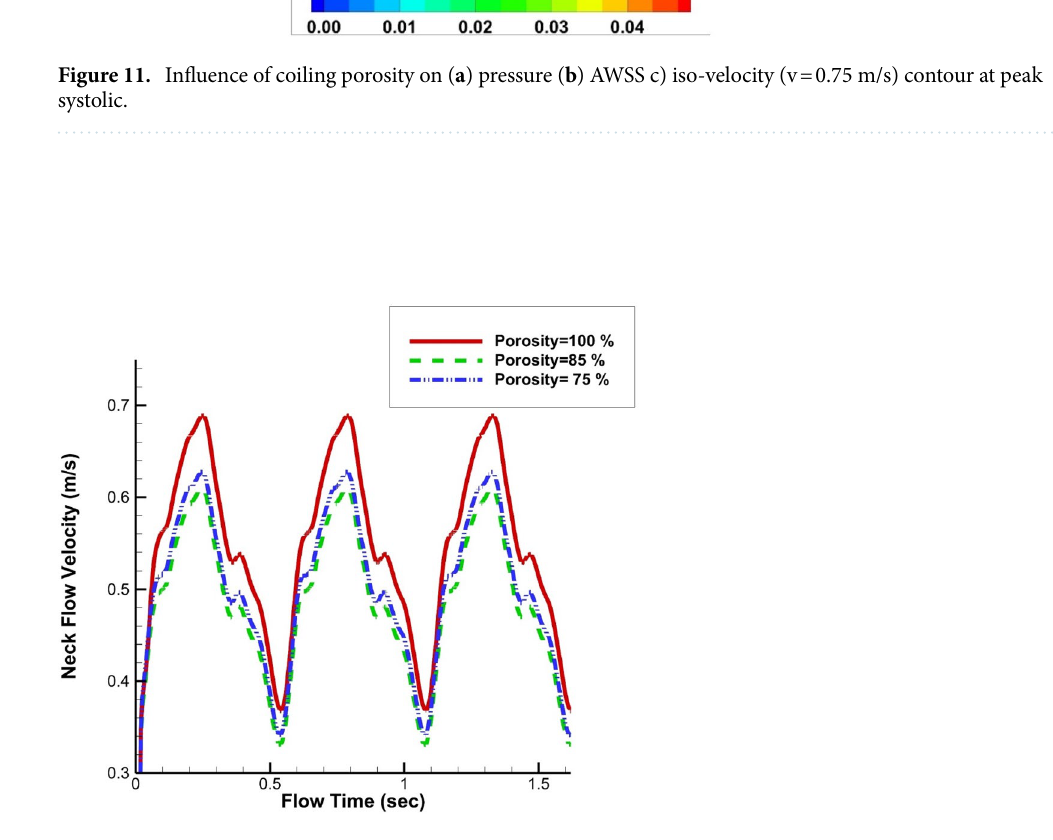
Figure 12. Variation of neck flow velocity in different coiling